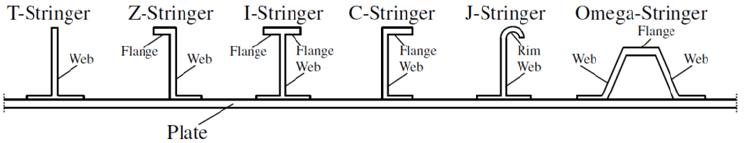
Figure 2: Cross sections of several kinds of